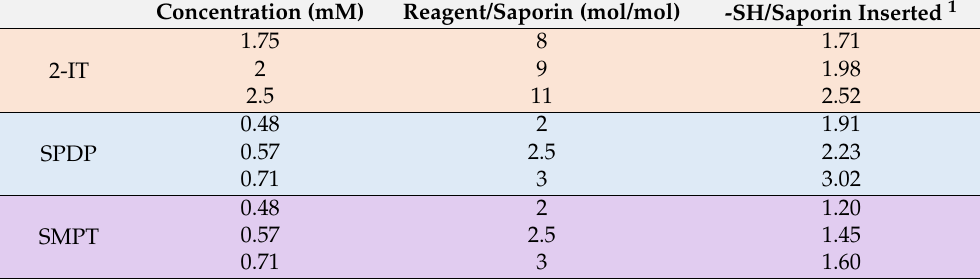
Table 3. Number of thiol groups (-SH) inserted per saporin molecule derivatized with the three heterobifunctional reagents, 2-IT, SPDP or SMPT, at different concentrations and molar ratios. Concentration